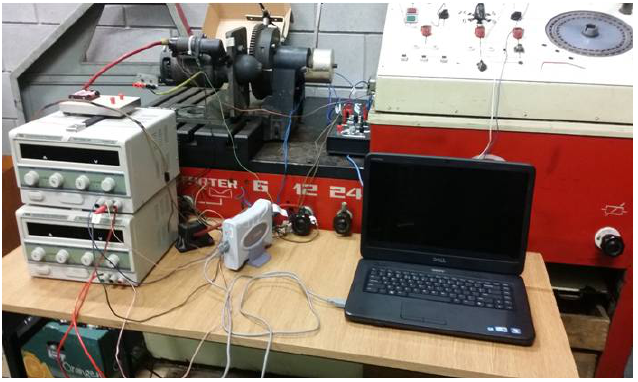
Figure 10. View of the measurement stand for testing the starter with the Hall sensor.